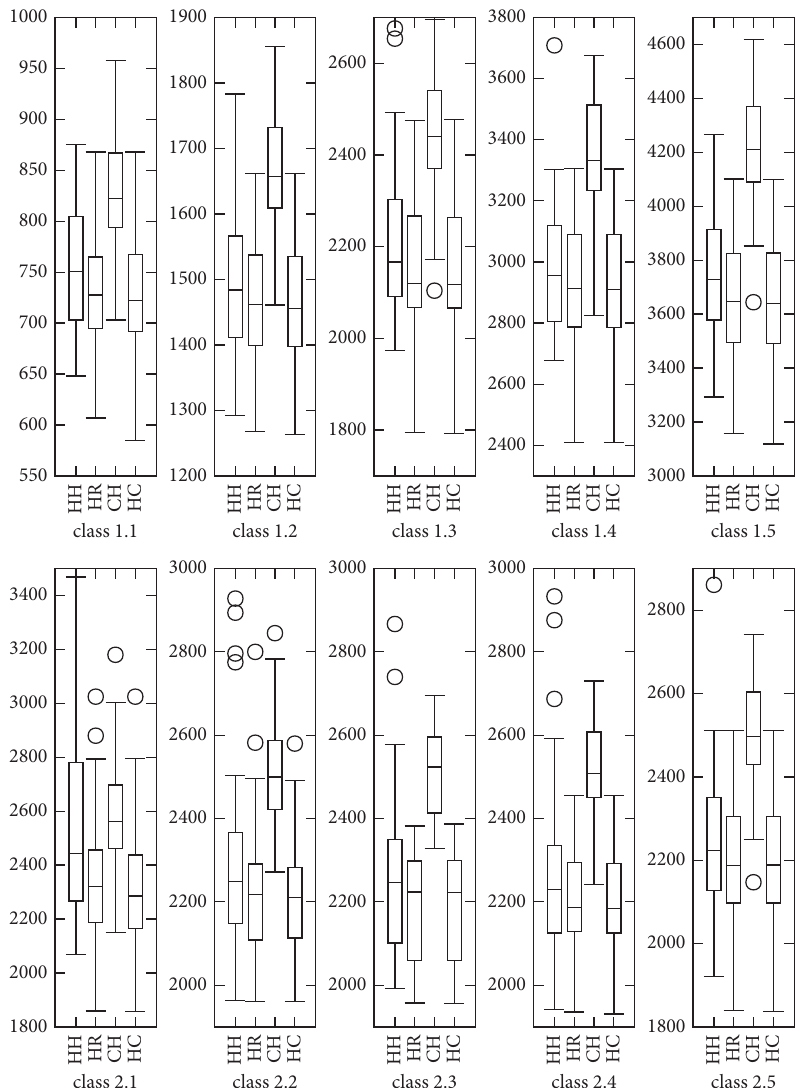
Figure 8: Boxplots of lengths of schedules (minimum, lower quartile, median, upper quartile, maximum, and outliers) returned by the LS algorithms for the benchmark given in [9] with cov �